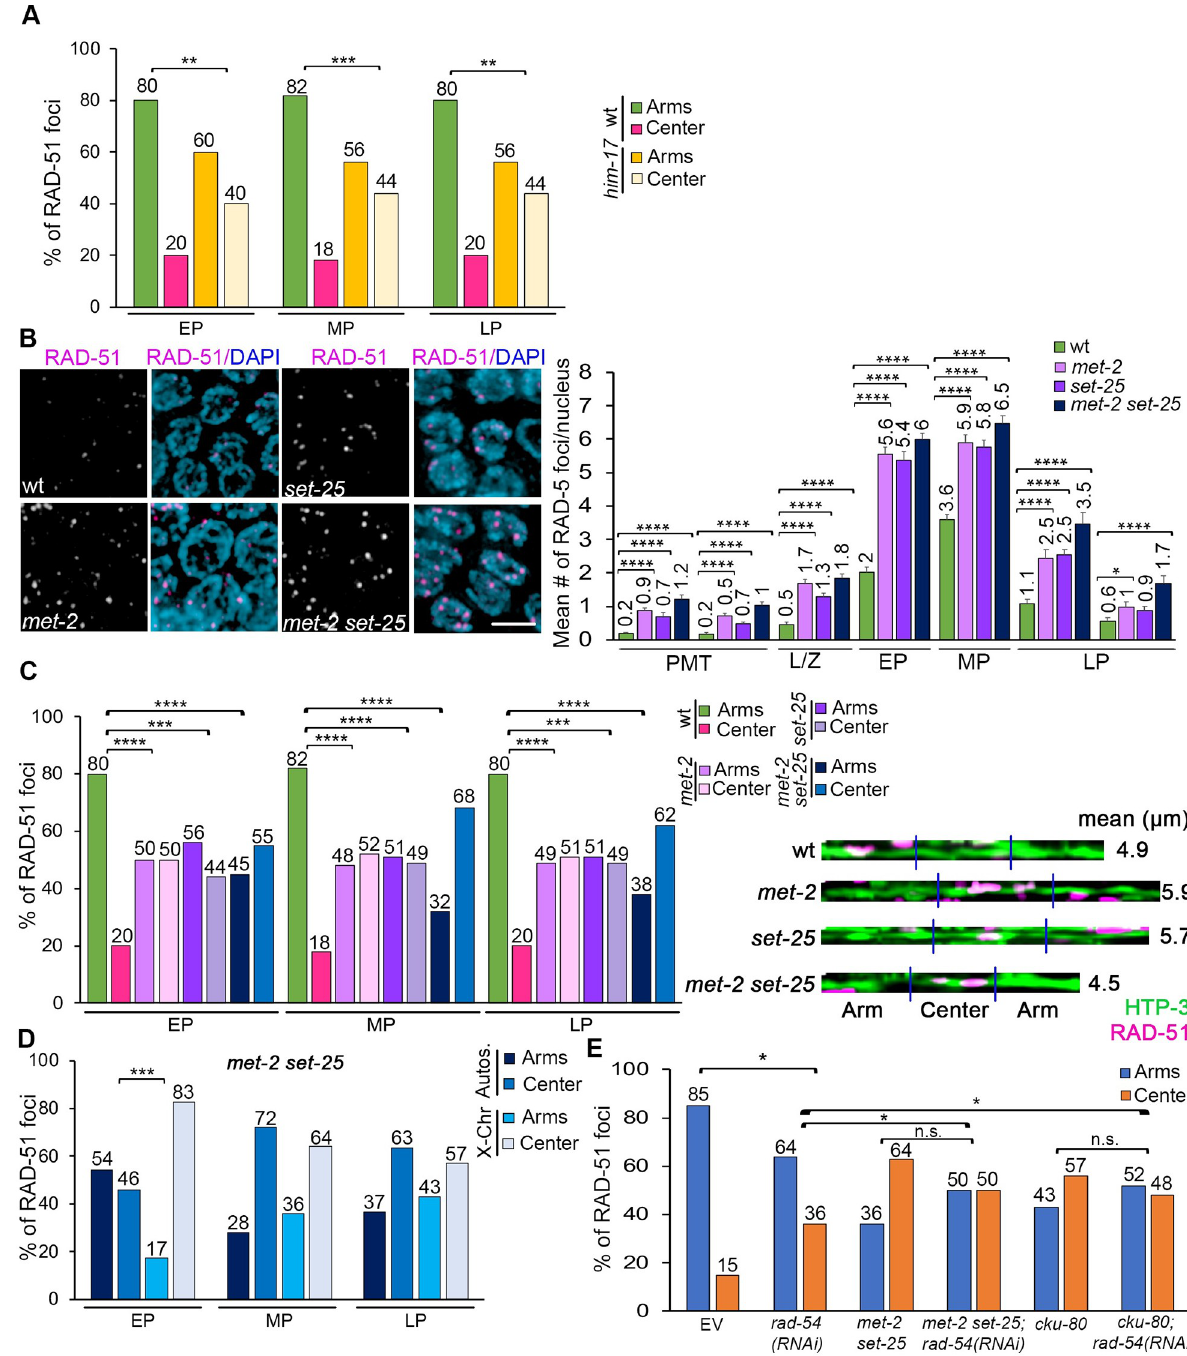
Fig 4. The chromatin landscape at the arms/center influences RAD-51 foci distribution. (A) Histogram shows the distribution of RAD-51 foci at the center versus the arms of the chromosomes throughout pachytene (early to late) in him-17 mutants compared to wild-type. him-17 mutants show an even distribution of RAD-51 foci between arms and center compared to wild-type worms. Percentages are indicated above each bar graph. �� p < 0.01, ��� p < 0.001 by Fisher’s exact test. (B) Left, high-resolution images of mid-pachytene nuclei (zone 5) immunostained for RAD-51 (magenta) and co-stained with DAPI (blue). Scale bar, 2 μ m. Right, histogram shows the mean number of RAD-51 foci/nucleus (y-axis) scored along each zone in the germlines (x-axis) of the indicated genotypes. At least 6 gonads were scored per genotype. Mean number of RAD-51 foci is indicated above each bar graph. Error bars represent SEM from technical repeats for each of two biological replicates. � p < 0.05, ���� p < 0.0001 by the two-tailed Mann-Whitney test, 95% C.I. (C) Left, histogram shows the distribution of RAD-51 foci at the center versus the arms of the chromosomes throughout pachytene in met-2 , set-25 , and met-2 set-25 mutants compared to wild-type. The distribution of RAD-51 foci in met-2 , set-25 , and met-2